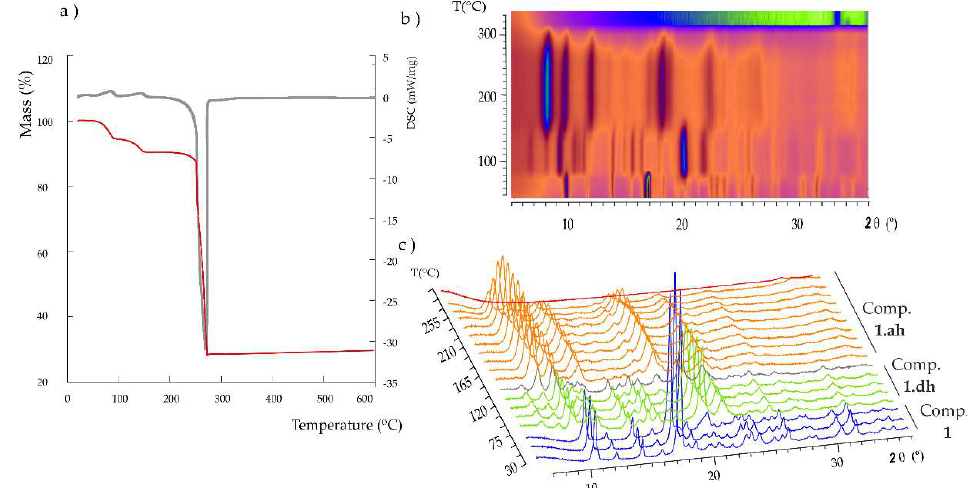
Figure 3. ( a ) TGA/DTA curves for 1 (exo down) . Variable temperature PXRD analysis for 1 from 30 °C to 315 °C ( b ) top 2D view and ( c ) 3D